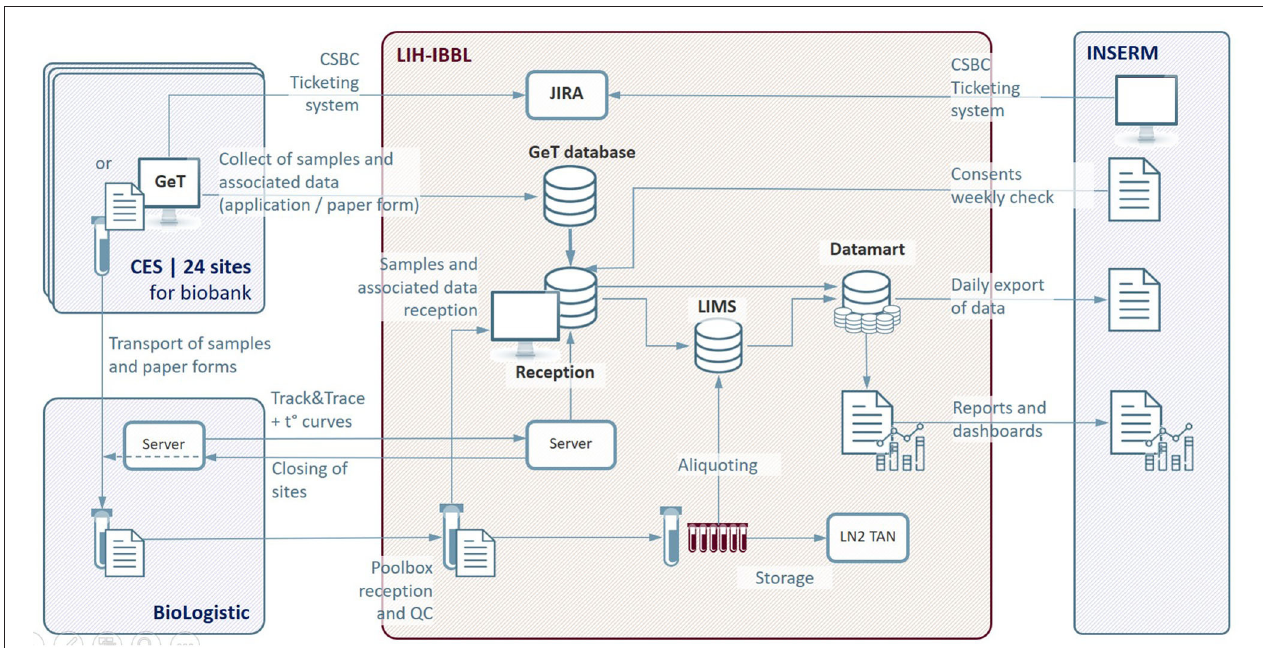
FIGURE 3 | IT architecture of the Constances Biobank Information System. CES, Centre d’Examens de Santé (Health Prevention Center); CSBC, Constances Service Desk; GeT, Greiner eHealth Technologies; LIH-IBBL, Luxembourg Institute of Health- Integrated BioBank of Luxembourg; LIMS, Laboratory Information Management System; LN2, liquid Nitrogen; INSERM, National Institute of Health and Medical Research; JIRA, bugs and incident management system; QC, Quality Control; t ◦ , temperature